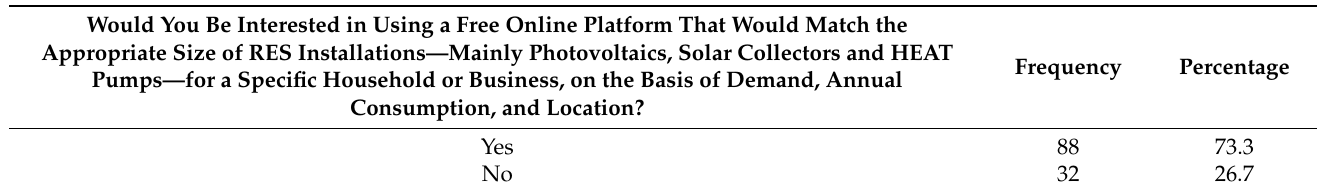
Table 17. Interest of entrepreneurs in the RES digital technology platform.